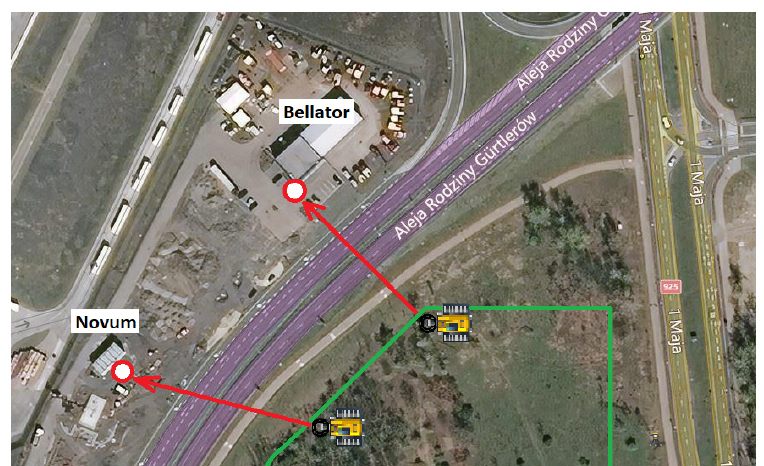
Figure 22. Vibration measurement area—vibration control in neighbouring objects (graphic by P. Dobrzycki).